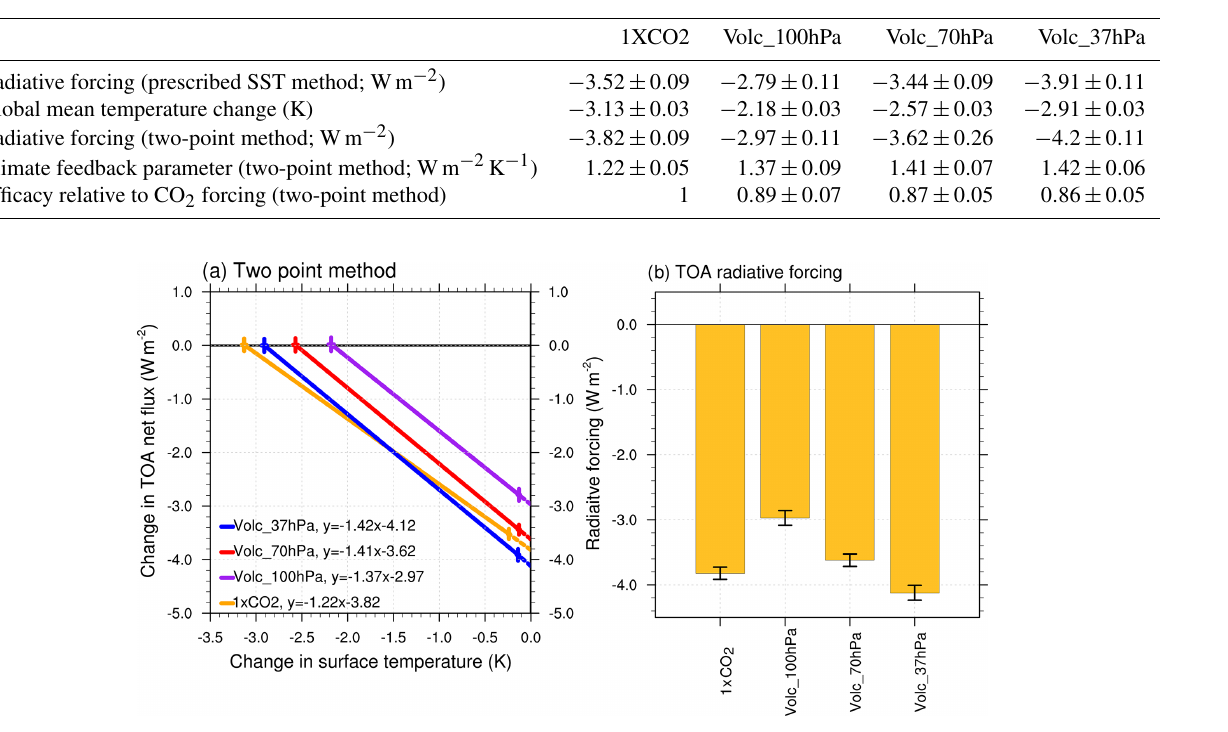
Table 1. Radiative forcing estimates and global annual mean temperature changes relative to the 2XCO2 case, and climate sensitivity and efficacy. Uncertainties for changes are estimated as 2 standard errors. Uncertainties are calculated from 60 annual mean differences for slab ocean and 30 annual means for prescribed SST experiments. The two-point method of estimating the radiative forcing, and climate sensitivity and efficacy are discussed in Sect. S1.